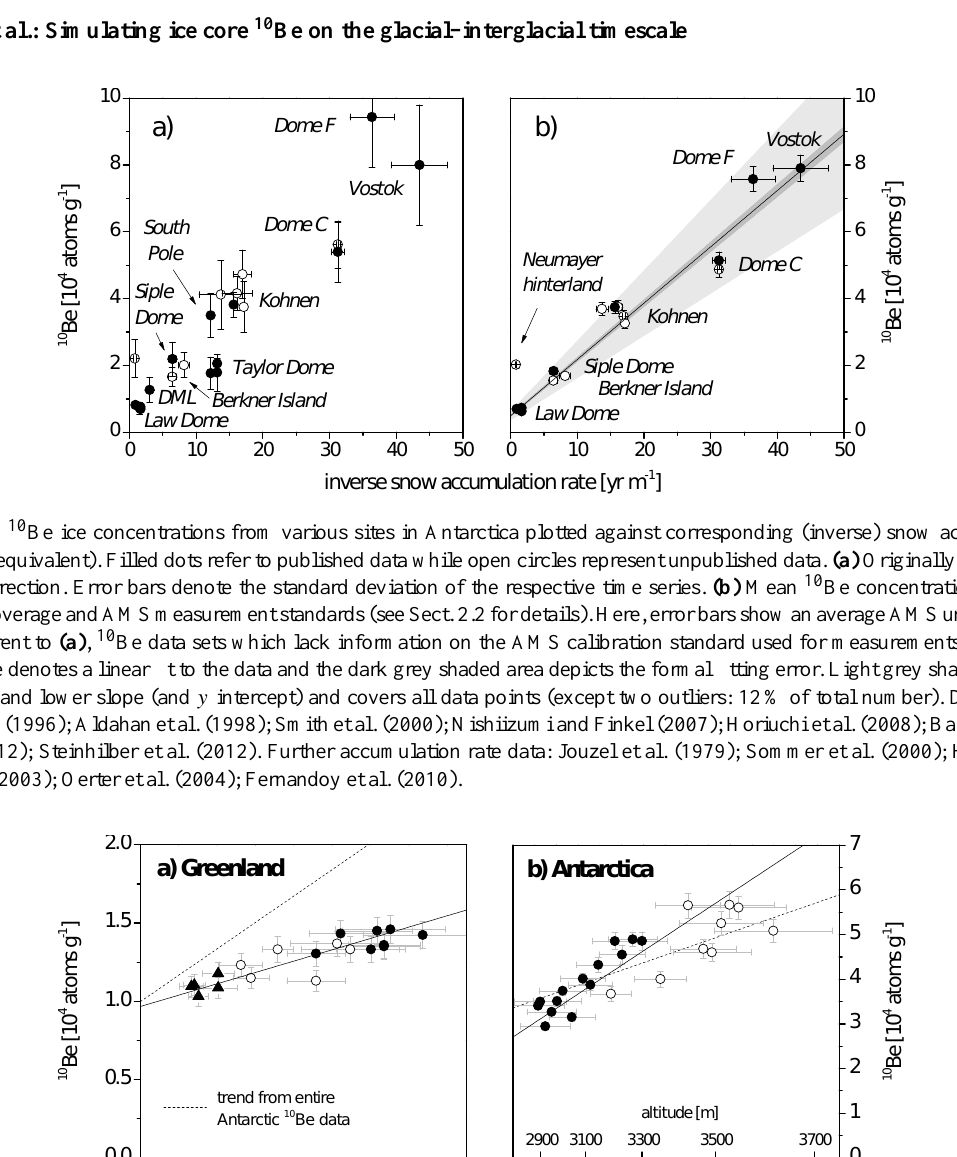
tion of (2 . 4 ± 0 . 4) × 10 4 atoms SCM − 1 (uncertainty from 7